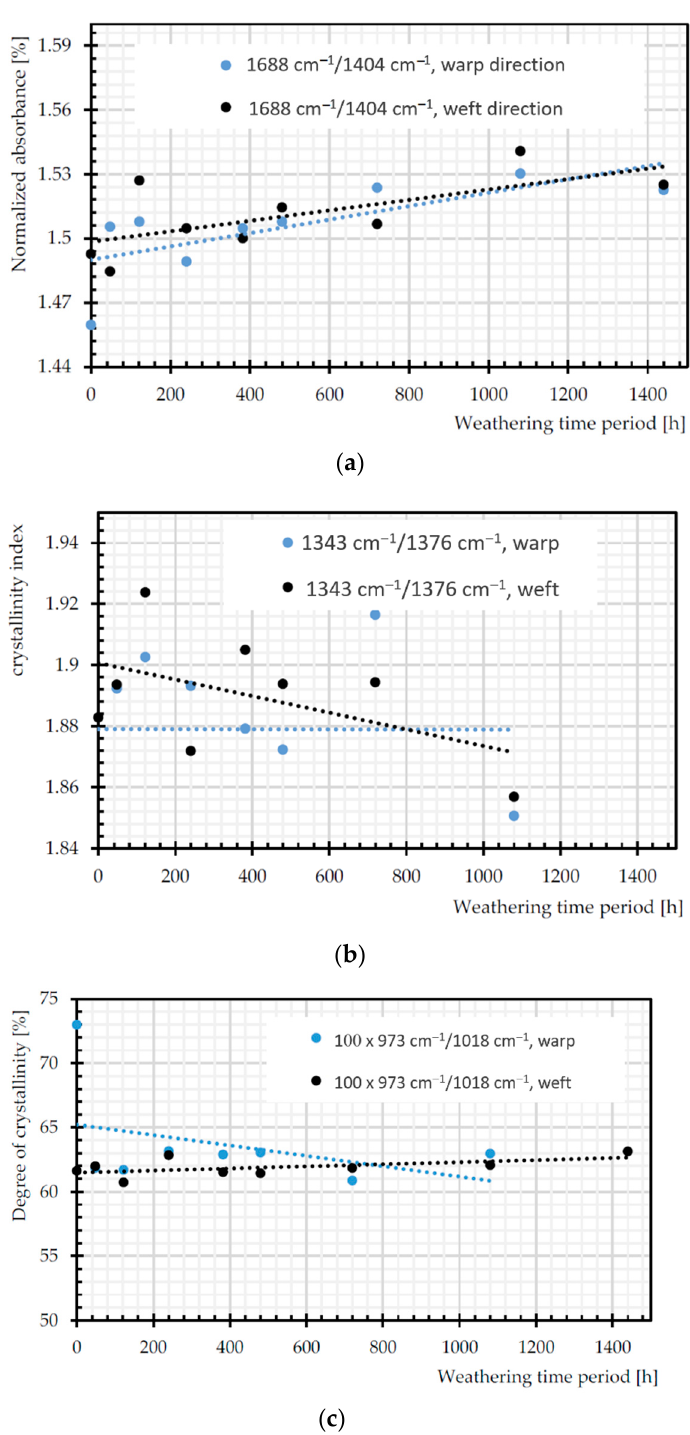
Figure 16. Normalized absorbance changes of: ( a ) C=O of carboxylic acid (1688 cm − 1 ); ( b ) crystallinity index (A1343 cm − 1 /A1376 cm − 1 ); and ( c ) degree of crystallinity (100 × (A973 cm − 1 /A1018 cm − 1 )).